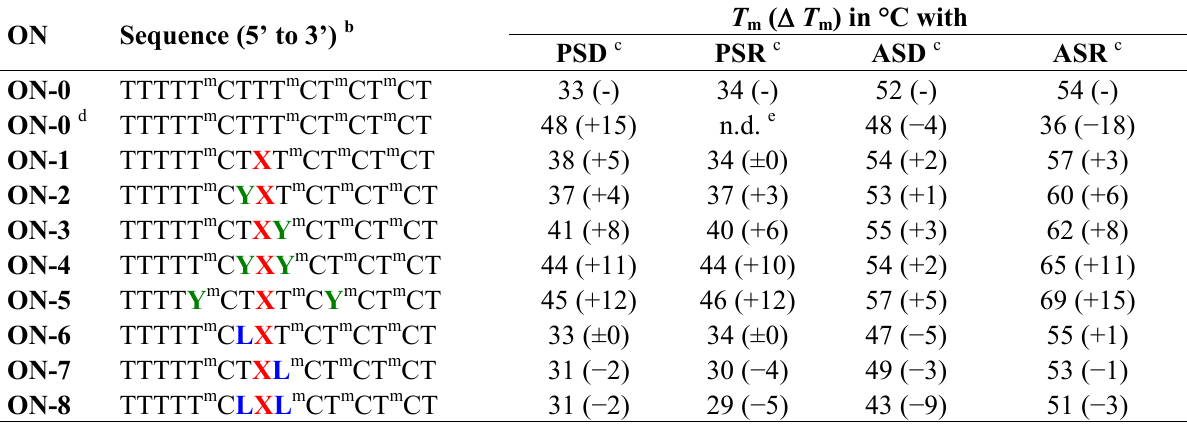
Table 1. T s of duplexes containing an ON-0–ON-8 oligonucleotide and ASD , ASR , m PSD , or PSR a .